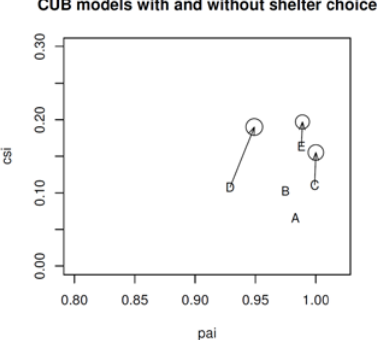
circles is proportional to shelter effect